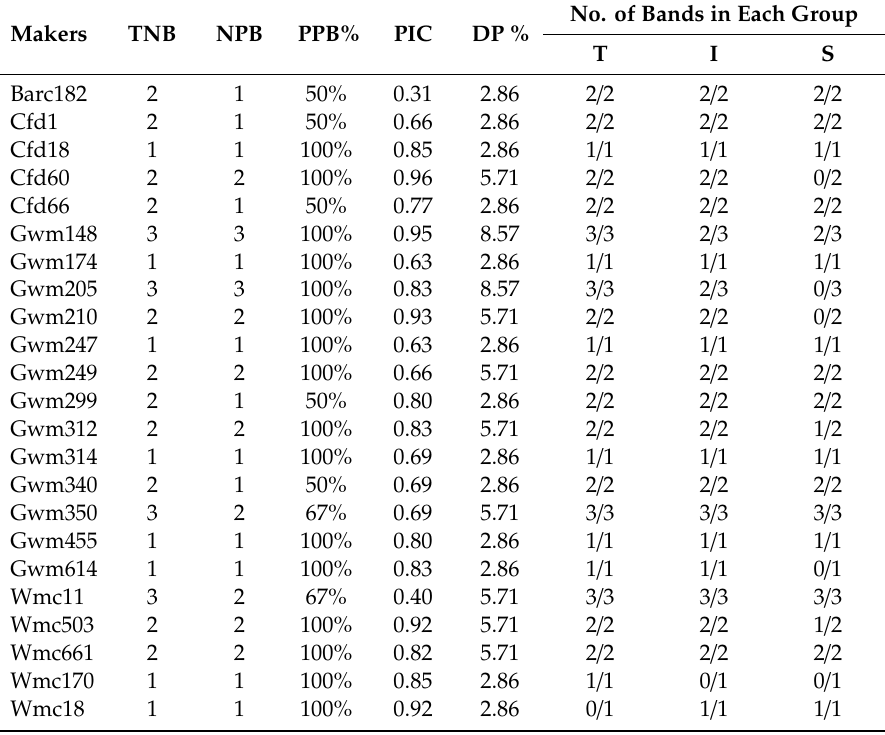
Table 4. List of 23 simple sequence repeat (SSR) makers, total number of bands, number of polymorphic bands, percentage of polymorphic bands, polymorphism information content, and discrimination power for eighteen wheat